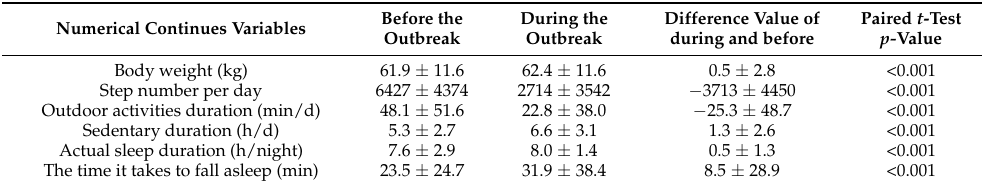
Table 4. Changes in body weight, step number, outdoor activities ‘duration, sedentary duration, and sleep duration during the COVID-19 outbreak compared to them before.